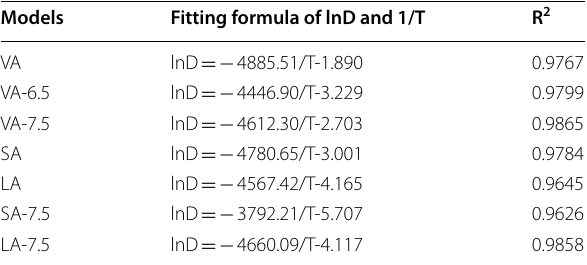
Table 2 Fitting Results of the Diffusion Coefficient versus System Temperature Base on Arrhenius Law